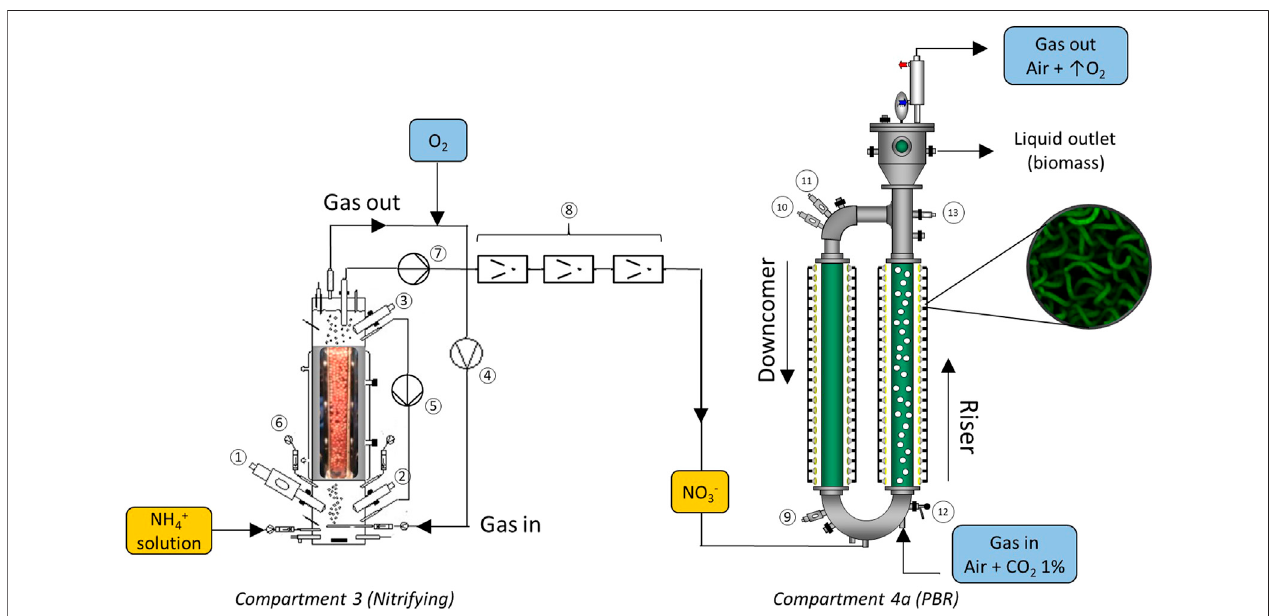
FIGURE 2 | Diagram for liquid connection between nitrifying and photosynthetic compartments (3-C4a). Nutrient solution containing ammonium is fed into Compartment 3 where nitri fi cation takes place. The output containing nitrate is pumped into Compartment 4a for photosynthesis. Nitrifying bioreactor elements: 1 - pHsensor,2,3pO 2 sensors,4-recirculatinggasclosed-loop,5-liquidrecirculationloop,6-acidandbaseadditions,7-outletpumpingsystem,8- fi ltrationsystemtoavoid nitrifying bacteria reaching the photobioreactor. Photobioreactor elements: 9,10-pH sensors, 11-pO2 sensor, 12-sampling valve, 13-biomass